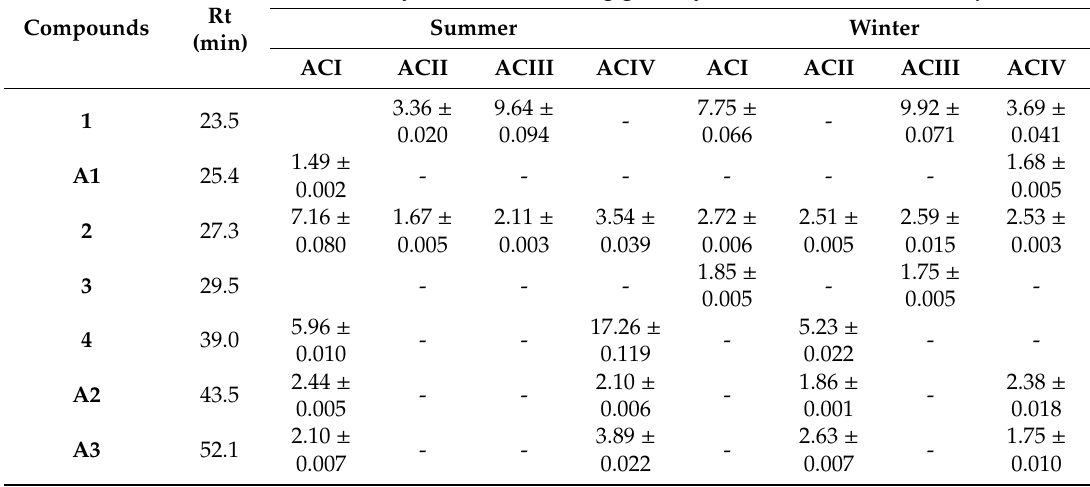
Table 1. Quantification of anthocyanidins (mg / g dry extract) calculated as carajurin content in four morphotypes of Arrabidaea chica Verlot (ACI-IV) collected in summer (S) and winter (W), and their retention times